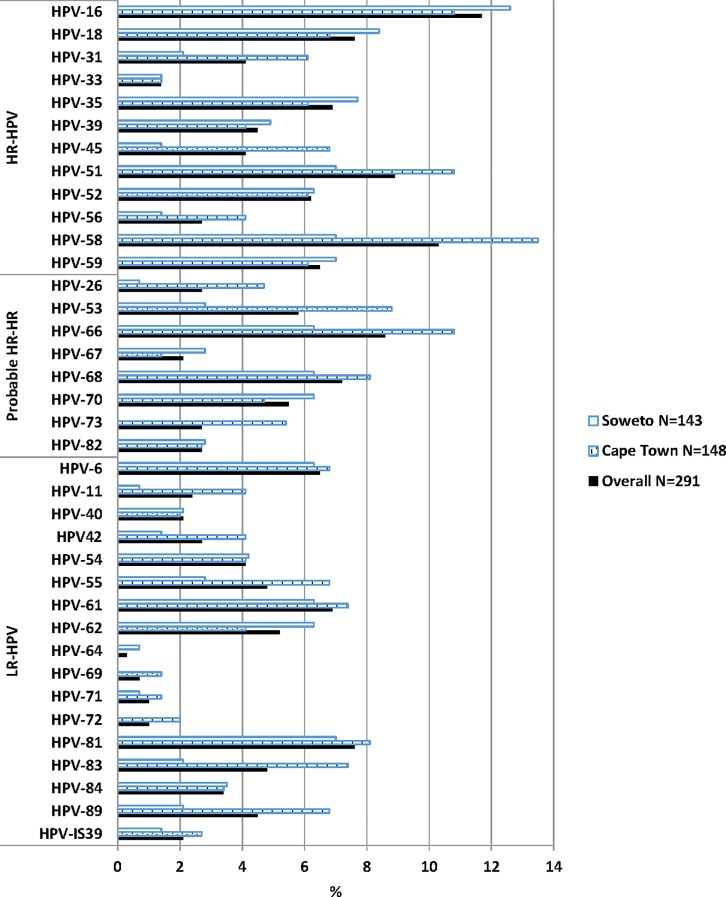
The prevalence of human papillomavirus genotypes according to study site in adolescents and young adults.HR-HPV types included HPV-16, -18, -31, -33, -35, -39, -45, -51, -52, -56, -58 and -59; probably or possible HR-HPV types included HPV-26, -53, -66, -67, -68, -70, -73 and -82; and low-risk (LR) HPV types HPV-6, -11, -40, 42, -54, -55, -61, -62, -64, -69, -71, -72, -81, -83, -84, -89 (HPV-CP6108) and–IS39 [22].